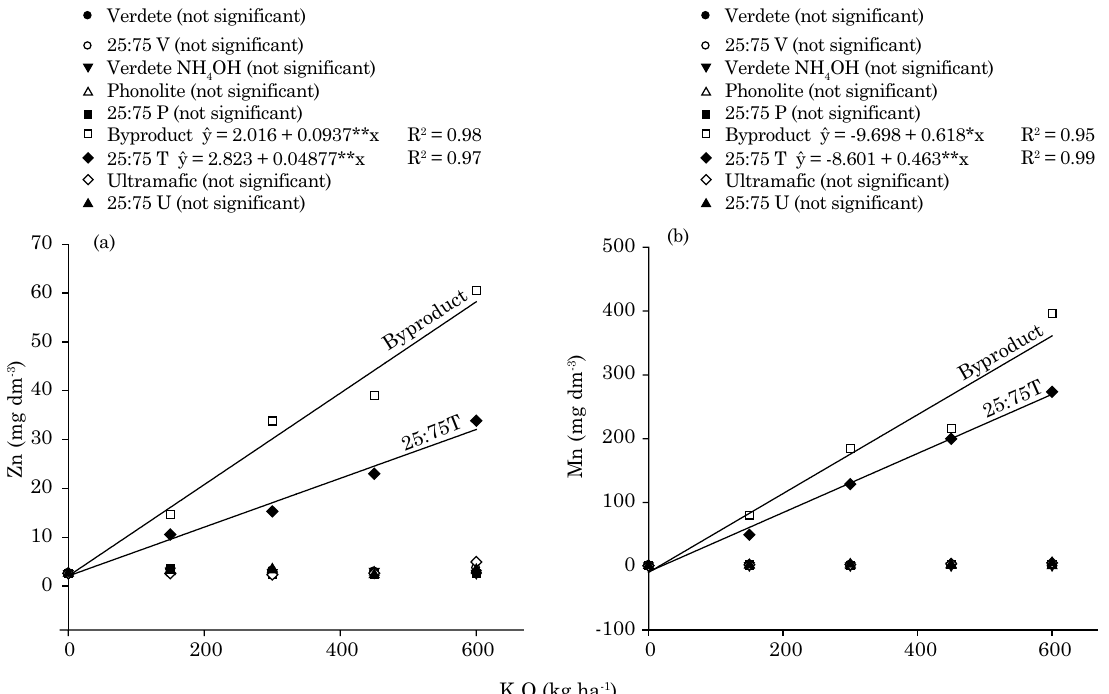
Figure 5. Availability of: (a) zinc, and (b) manganese in soil according to treatments after 45-day incubation. * Significant at 5 % by Scott Knott test. Non-significant for: verdete, verdete with NH 4 OH, 25:75V, phonolite, 25:75P, ultramafic rock,